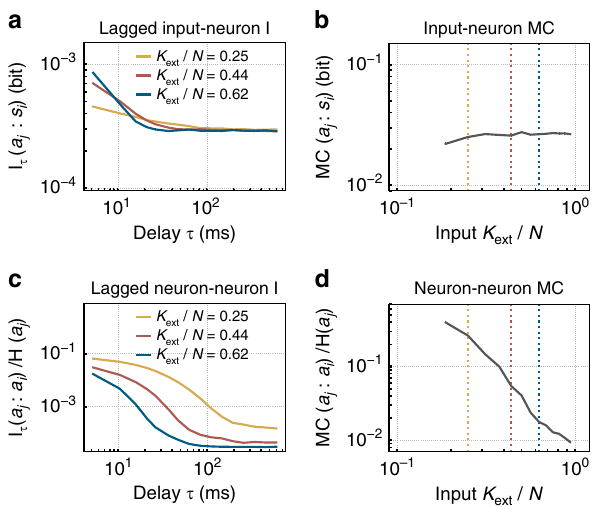
Fig. 7 Long lasting memory accompanies critical network dynamics. a Memory about the input s i as read out from neuron a j after a time lag τ is quanti fi ed by the mutual information I τ ( a j , s i ). Here, high degrees of the external input K ext are favorable for memory on short timescales, whereas low K ext is favorable on larger timescales. b The memory capacity (MC) stays fairly constant, despite of a decreased coupling to the stimulus for low K ext . c The lagged I between the activity of pairs of neurons indicates increasing memory for decreasing K ext , also visible in the memory capacity (MC) ( d ). The selection of K ext / N in a and c is marked by dashed vertical lines in b and d